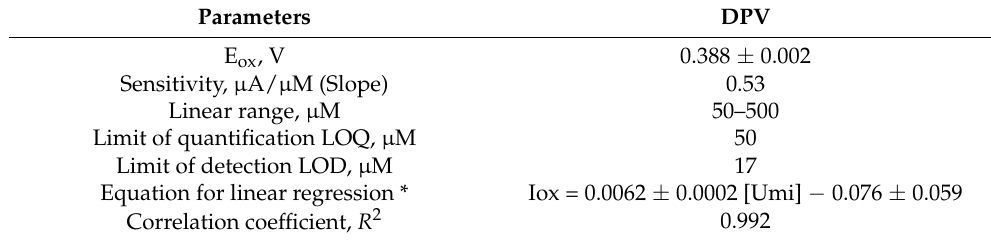
Table 1. Electroanalytical parameters of quantitative Umi assay with SPE/SWCNT. Parameters DPV E ox , V 0.388 ± 0.002 Sensitivity, µ A/ µ M (Slope) 0.53 50–500